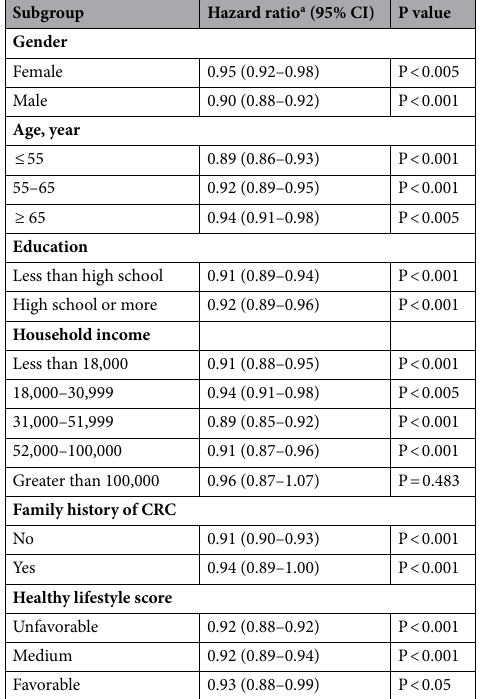
Table 3. Hazard ratio (95% CI) of CRC events per 1-number increment in healthy sleep score among participants. a Hazard ratios (95% CI) were adjusted for age, sex, education, household income, family history of CRC, healthy lifestyle score.